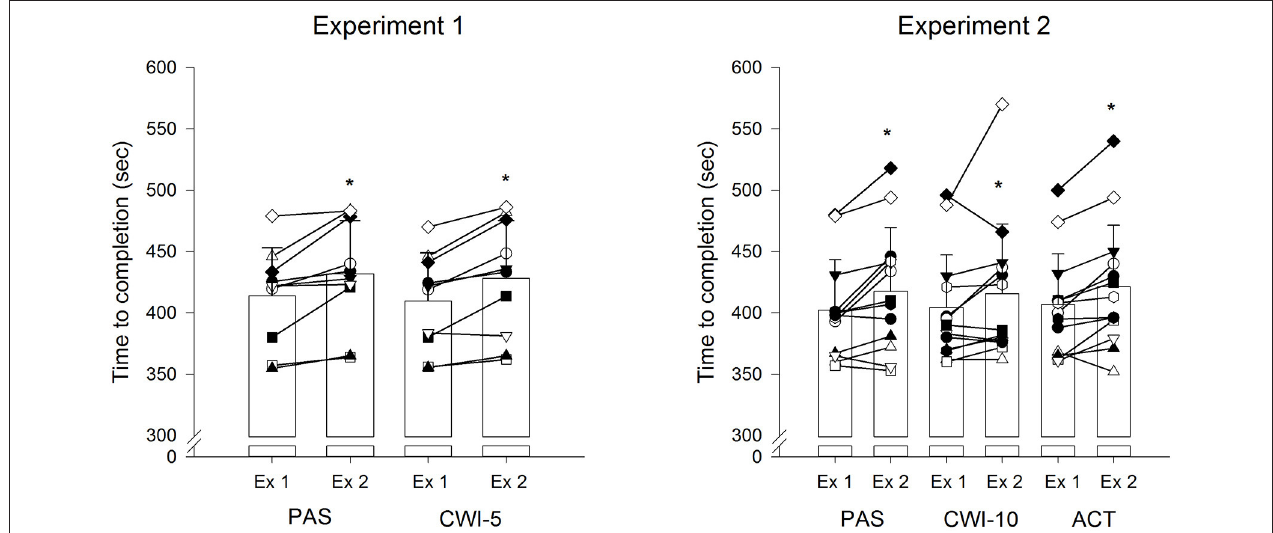
FIGURE 2 | Individual and mean ( ± SD) cycling completion times for the 4-km time trials (TT) during Exercise 1 (Ex 1, pre-recovery) and Exercise 2 (Ex 2, post recovery) for the experimental conditions. PAS, passive recovery; CWI-5, 5min cold water immersion; CWI-10, 10min cold water immersion; ACT, active recovery. *Significantly different from Ex1 ( P < 0.05).